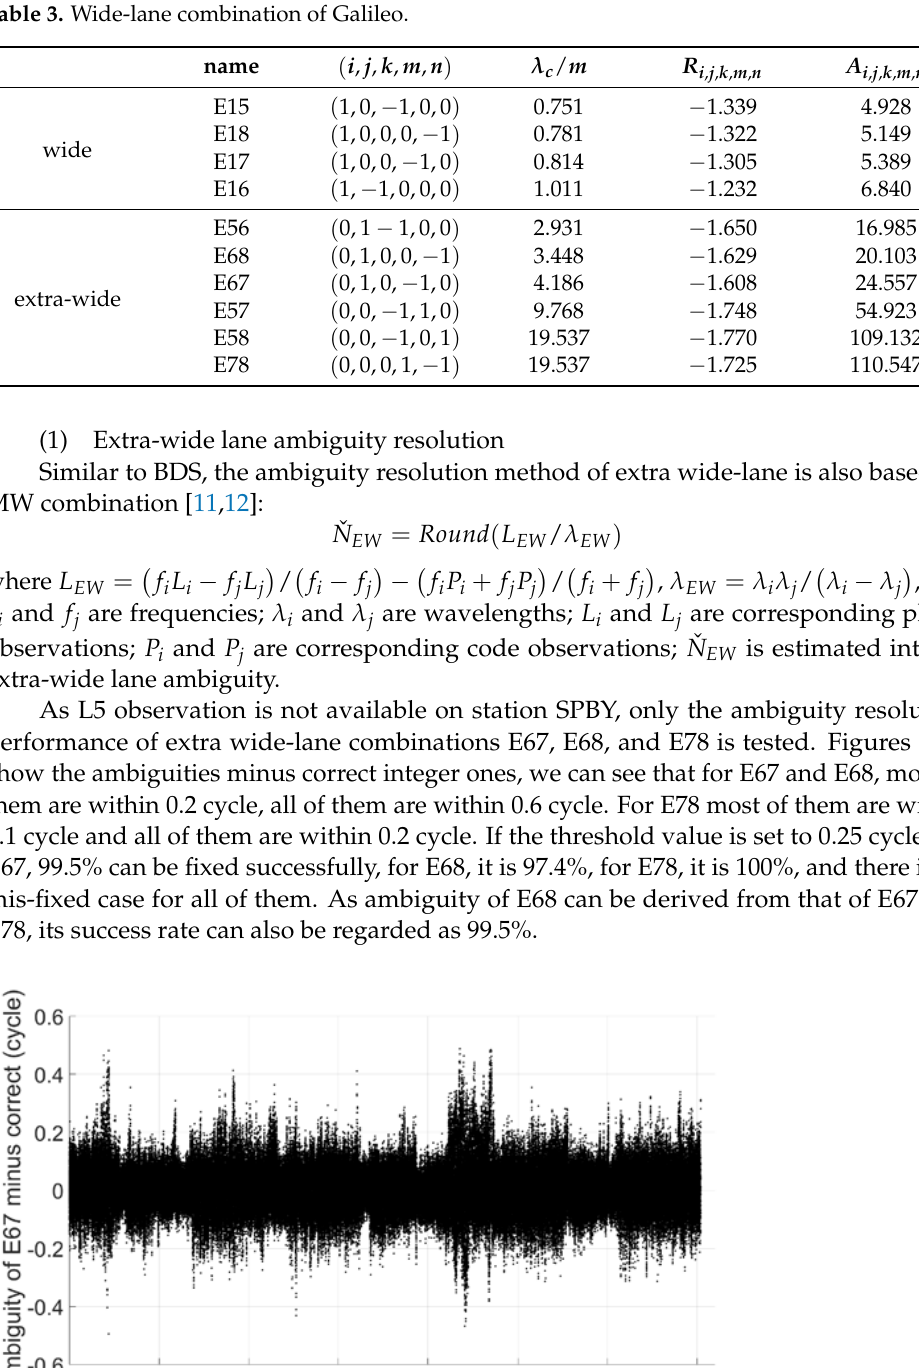
Figure 10. Extra wide-lane E68 ambiguity minus correct integer ambiguity (Galileo).